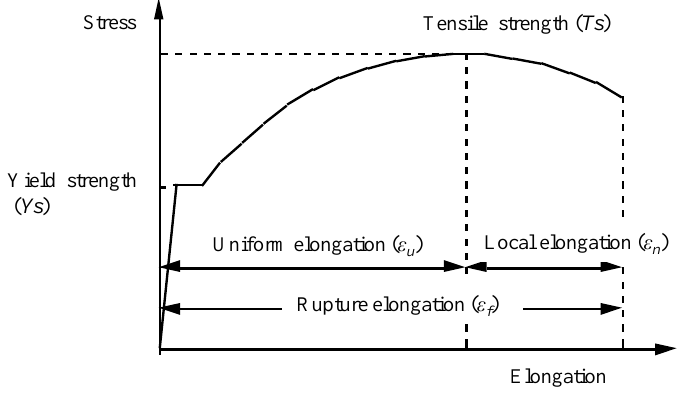
Figure 5. Schematic diagram of stress-strain correlation.